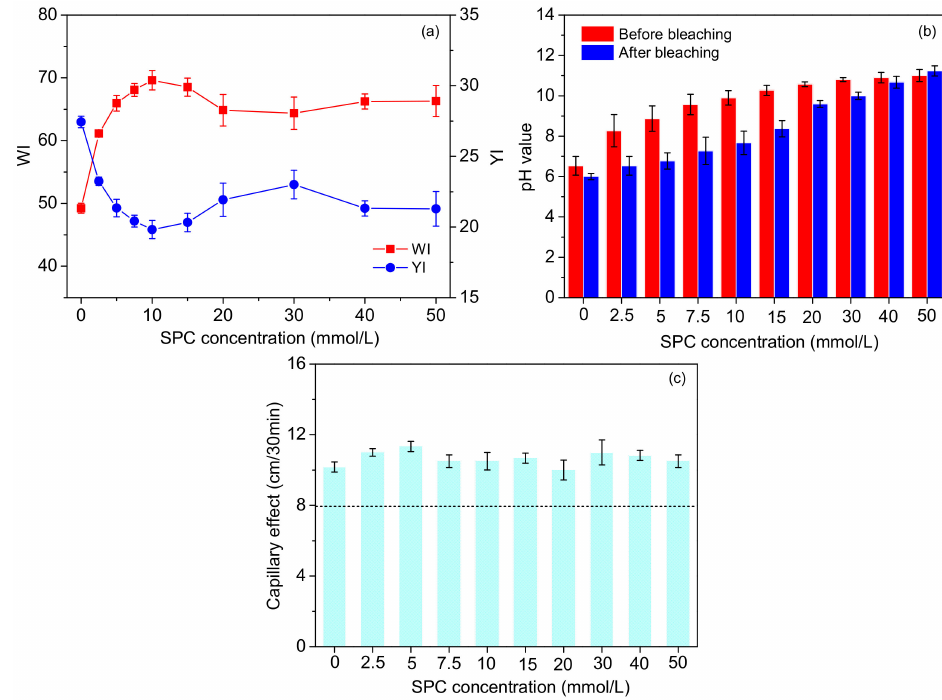
Figure 2. Effects of the SPC concentration on the WI/YI ( a ) and capillary effect ( c ) of the fabrics; pH variations of the processing solutions before and after bleaching ( b